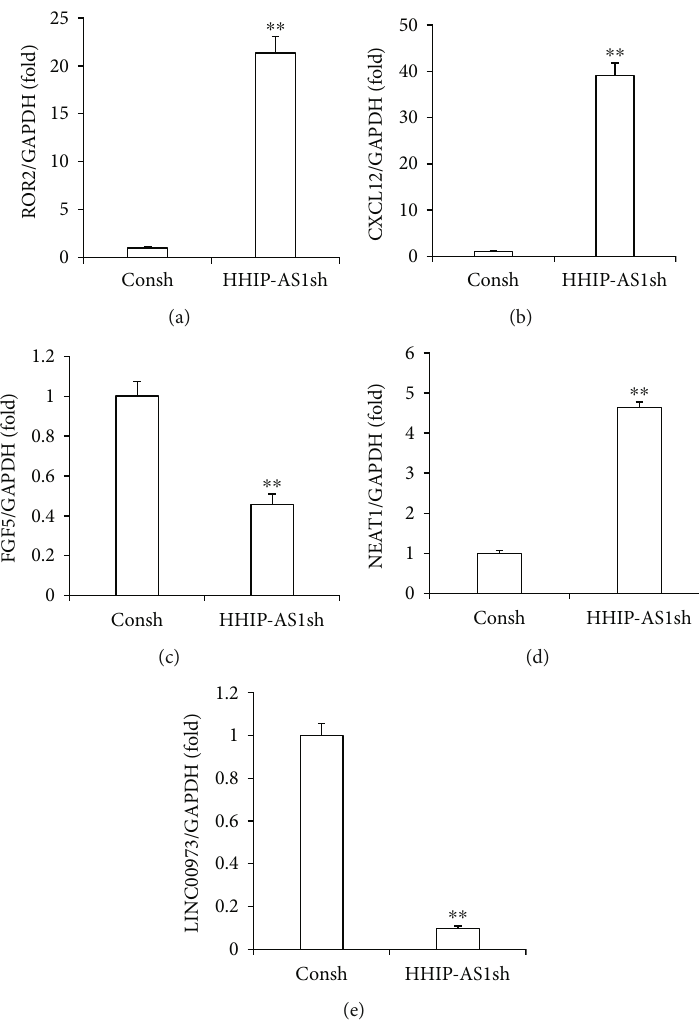
Figure 5: HHIP-AS1 knockdown resulted in upregulation of ROR2, CXCL12, and NEAT1 and downregulation of FGF5 and LINC00973 in PDLSCs. Real-time RT-PCR results showed the expressions of (a) ROR2, (b) CXCL12, (c) FGF5, (d) NEAT1, and (e) LINC00973. GAPDH was used as internal control. Student ’ s t -test was performed to determine statistical signi fi cance. All error bars represent the SD ( n = 3 ). ∗∗ P ≤ 0 : 01